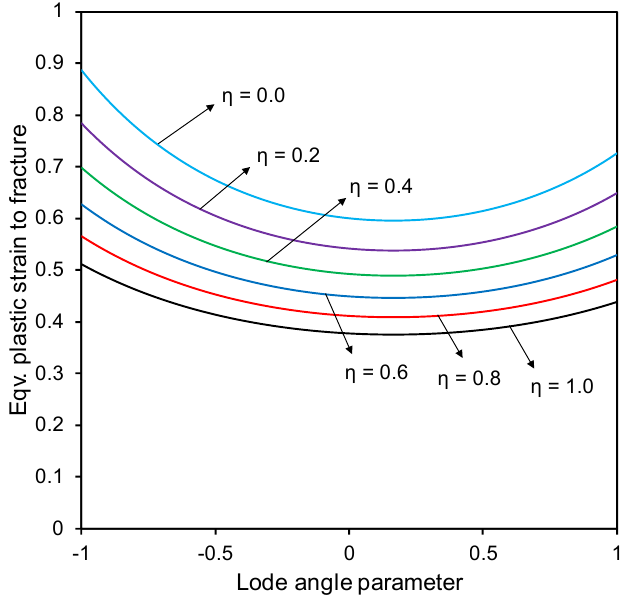
Figure 3. Lode angle parameter dependence of the proposed fracture model for C 1 = 0.85, C 2 = 2.0, C 3 = 0.2.